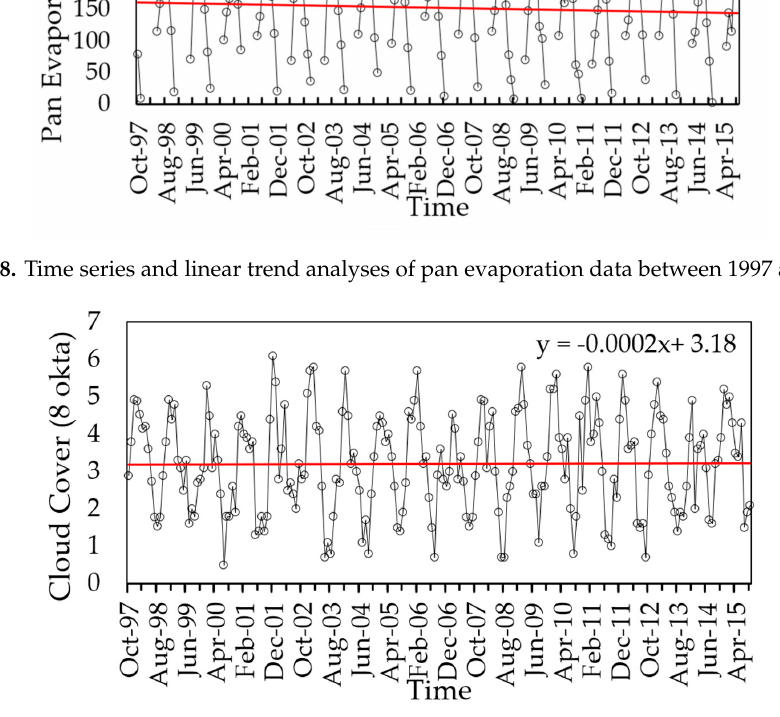
Figure 9. Time series and linear trend analyses of cloud cover data between 1997 and 2015.